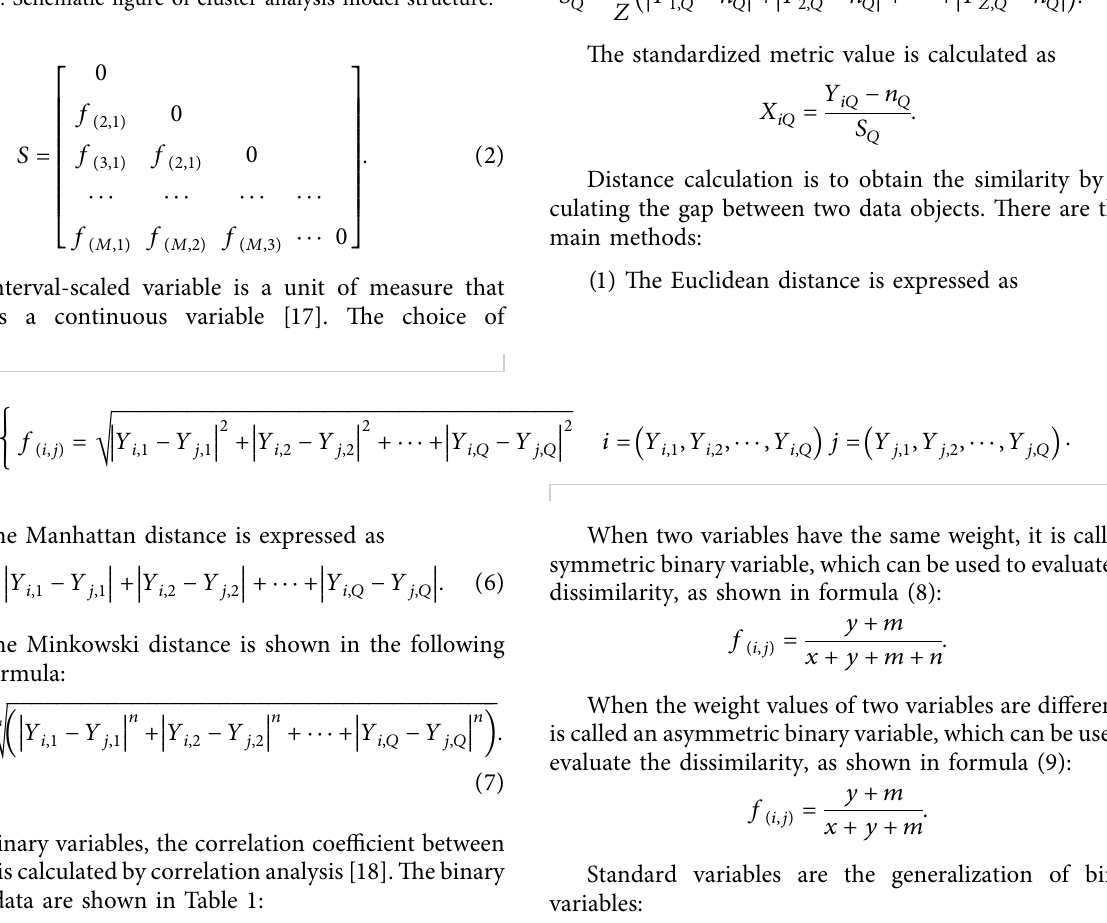
Figure 2: Schematic figure of cluster analysis model structure.